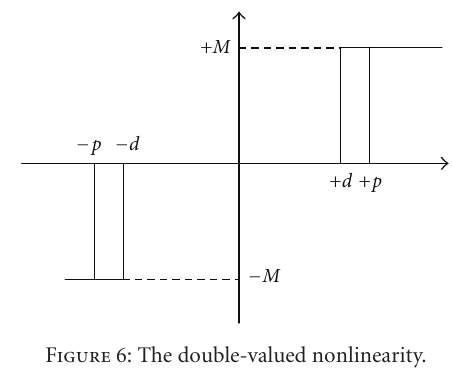
Figure 6: The double-valued nonlinearity.